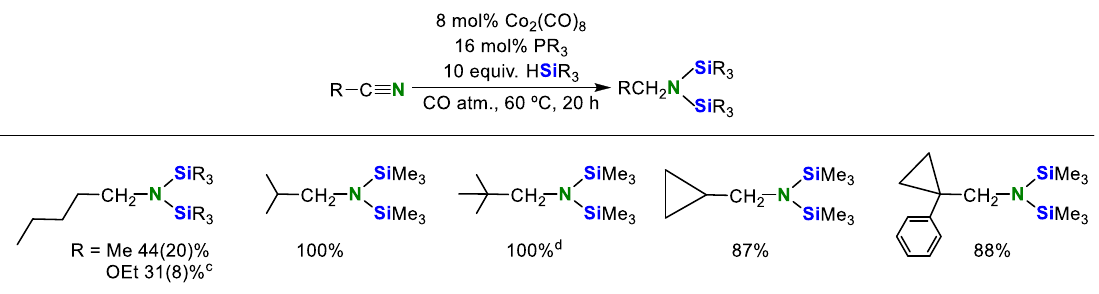
Table 2. Cobalt carbonyl catalyzed double hydrosilylation of aliphatic nitriles a,b .